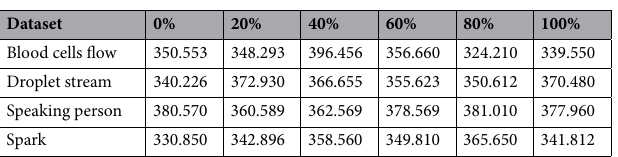
Table 3. Variance